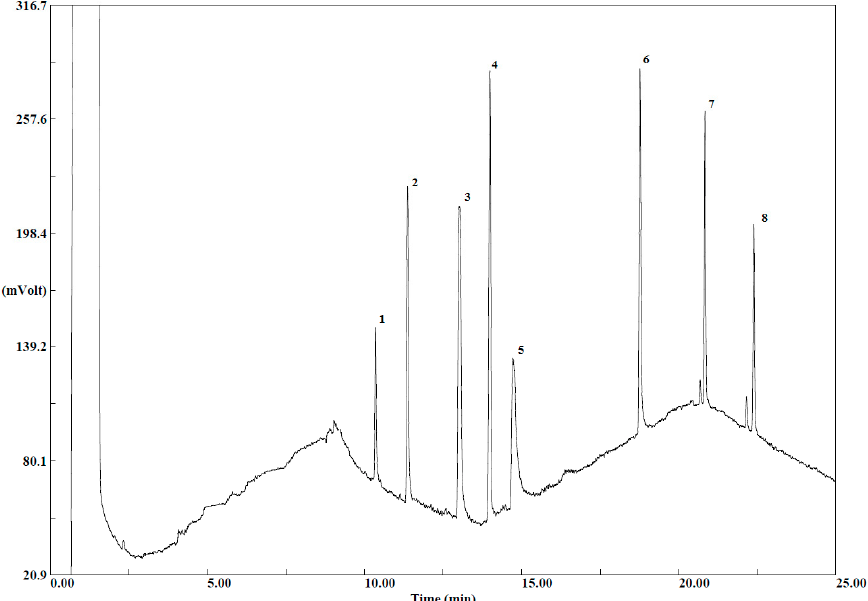
Figure 2. Chromatogram obtained for 10 g of spiked apple sample at the concentration level 2 mg·kg − 1 for each pesticide by using QuEChERS-GC-ECD, 1: Tolclofos-methyl, 2: Chlorpyrifos, 3: Captan, 4: α -endosulfan, 5: Imazalil, 6: Phosalone, 7: α -cypermethrin, 8: Deltamethrin.